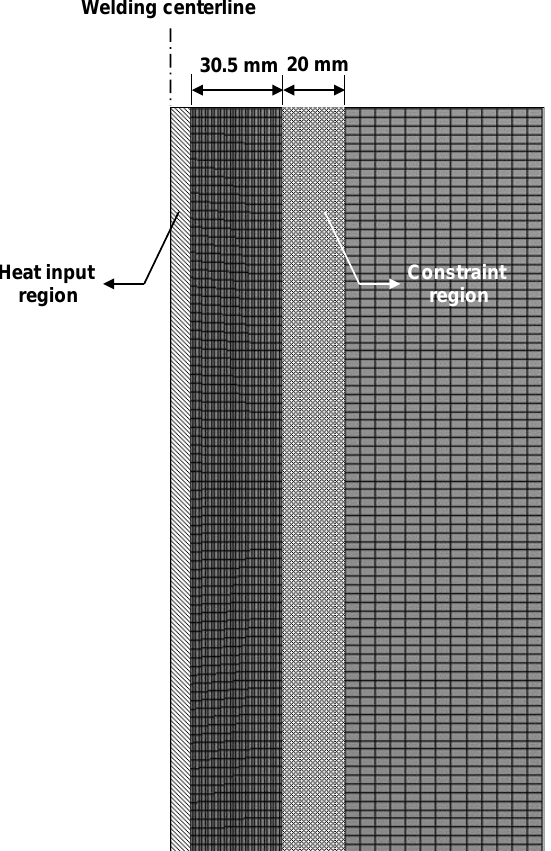
Figure 12. FE model for thermal elasto-plastic analysis.